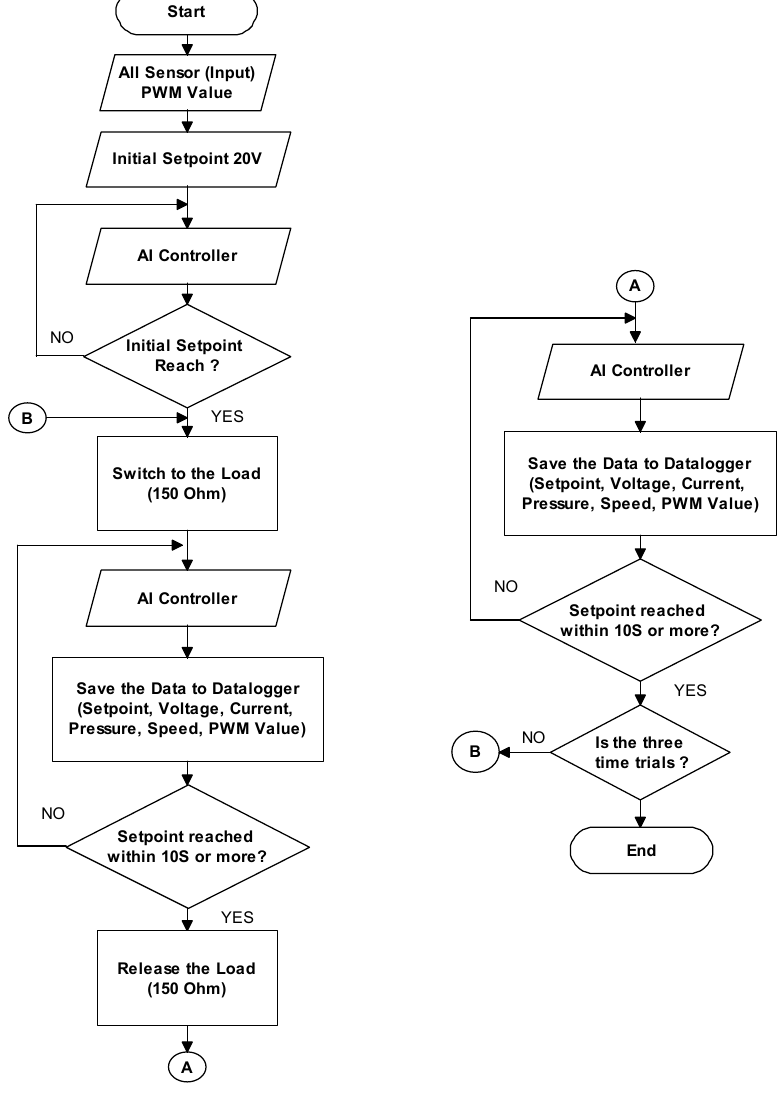
Figure 14. Flowchart Scenario 2.